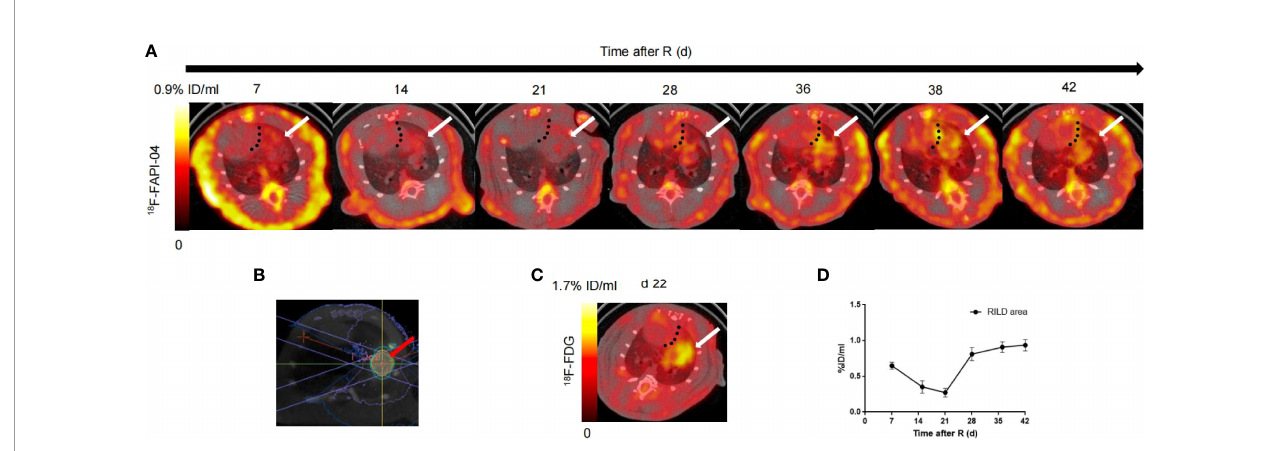
FIGURE 4 | In vivo imaging of 18 F-NOTA-FAPI uptake in longitudinal study. (A) Static PET/CT matched axial slices from the same rat subjected to radiation and scanned 1 h after injection of 18 F-FAPI on days 7, 15, 21, 28, 36, 38 and 42 after radiation treatment. Dashed lines separate tracer uptake in lung from uptake in heart, and white arrows show representative regions of interest (2-dimensional) drawn over area of RILD. (B) On the cross section, a schematic diagram of the radiation target (red arrow) of the right lung of rats, an arc fi eld were used to irradiate the lung in a targeted way with a homogeneous dose. (C) Static PET/CT matched axial slices in the same rat scanned 1 h after injection of 18 F-FDG on day 22 after radiation treatment. (D) Corresponding time – activity curves for RILD from day 7 to day 42 after radiation (average and SD, n = 3).